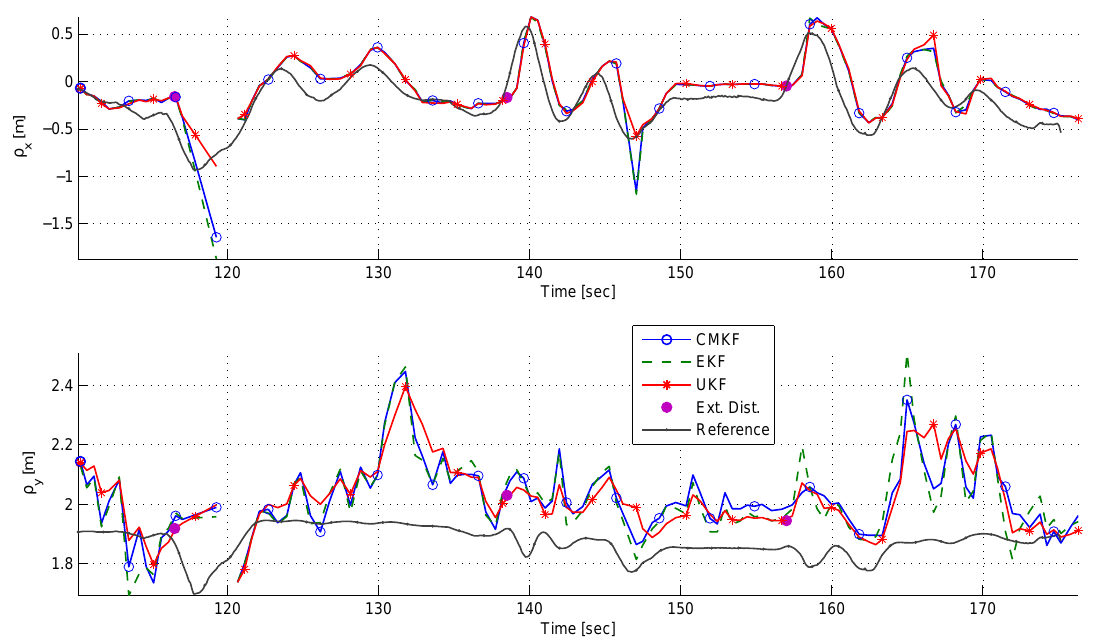
Figure 16. A comparison of ρ x ( top ) and ρ y ( bottom ) estimation using different filters in the semi-static experiment.